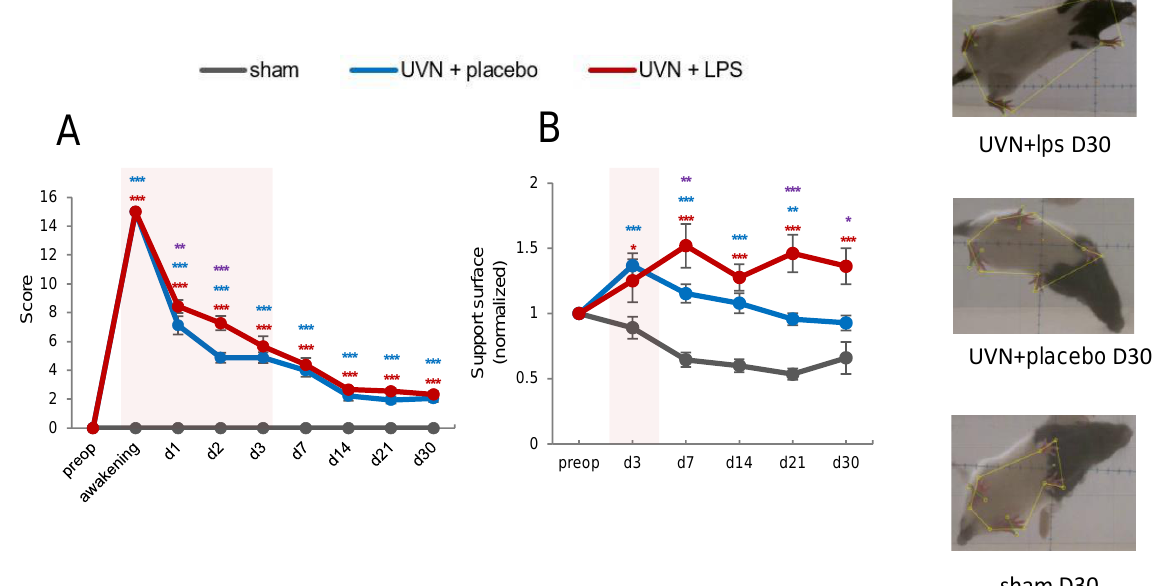
Figure 5. Acute LPS treatment enhances significantly vestibular syndrome intensity and postu- ral instability following UVN. ( A ) Evolution of the score on the qualitative scale for the sham, UVN+placebo, and UVN+LPS groups. ( B ) Evolution of the support surface for the sham, UVN+placebo, and UVN+LPS groups. A light red box is positioned on the curve to indicate the period corresponding both to the acute phase of the vestibular syndrome (d1 to d3) and to the thera- peutic window. Each point represents the group mean with error bars representing SEM. * p < 0.05; ** p < 0.01; *** p < 0.001, two-way RM ANOVA, post hoc Tukey: sham and UVN+placebo comparison is indicated by a blue *; sham and UVN+LPS comparison is indicated by a red *; UVN+placebo and UVN+LPS comparison is indicated by a purple